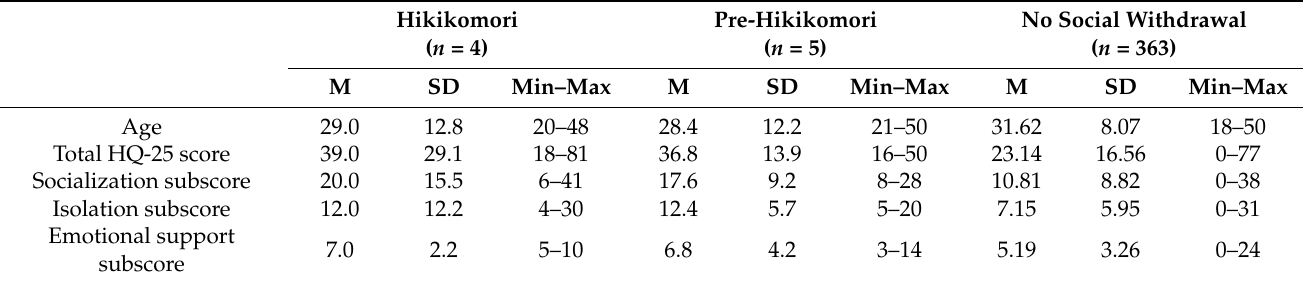
Table 5. Descriptive statistics for the HQ-25, according to lifetime history of